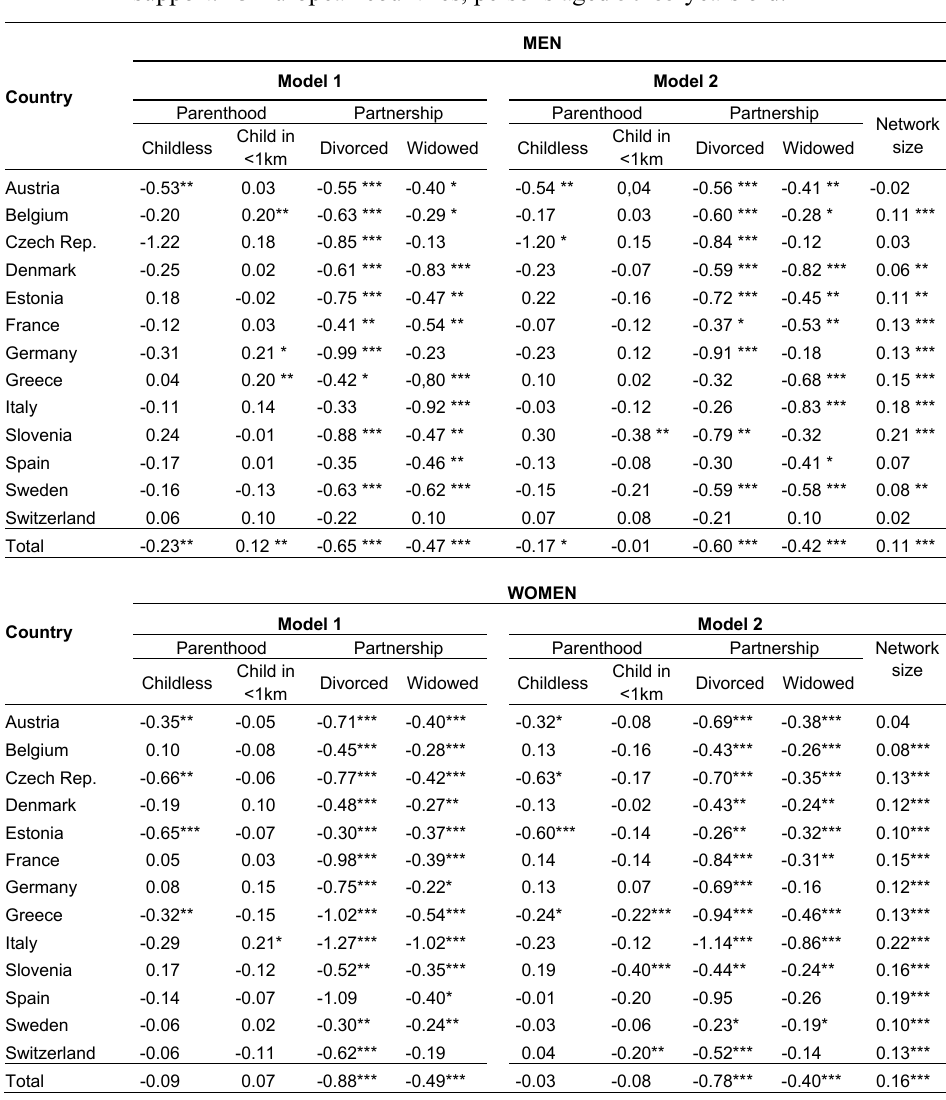
Table 3 : Linear regression of life satisfaction on childlessness, singlehood, and social support. 13 European countries, persons aged 50-85 years